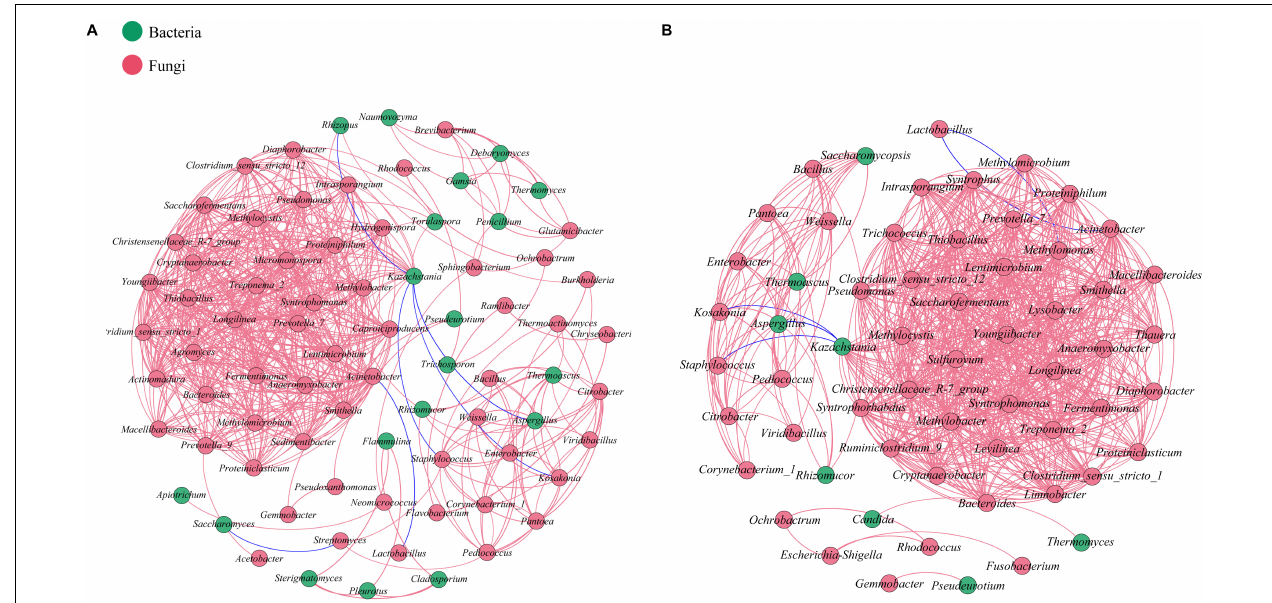
FIGURE 5 | Relationships among microbial communities of SCSSF (A) and TCSSF (B) processes. A connection stands for a significant ( p < 0.05) and strong (Spearman’s | ρ | > 0.7) correlation. The color of each node is proportional to the types of microorganisms. Bacteria, red; fungi,